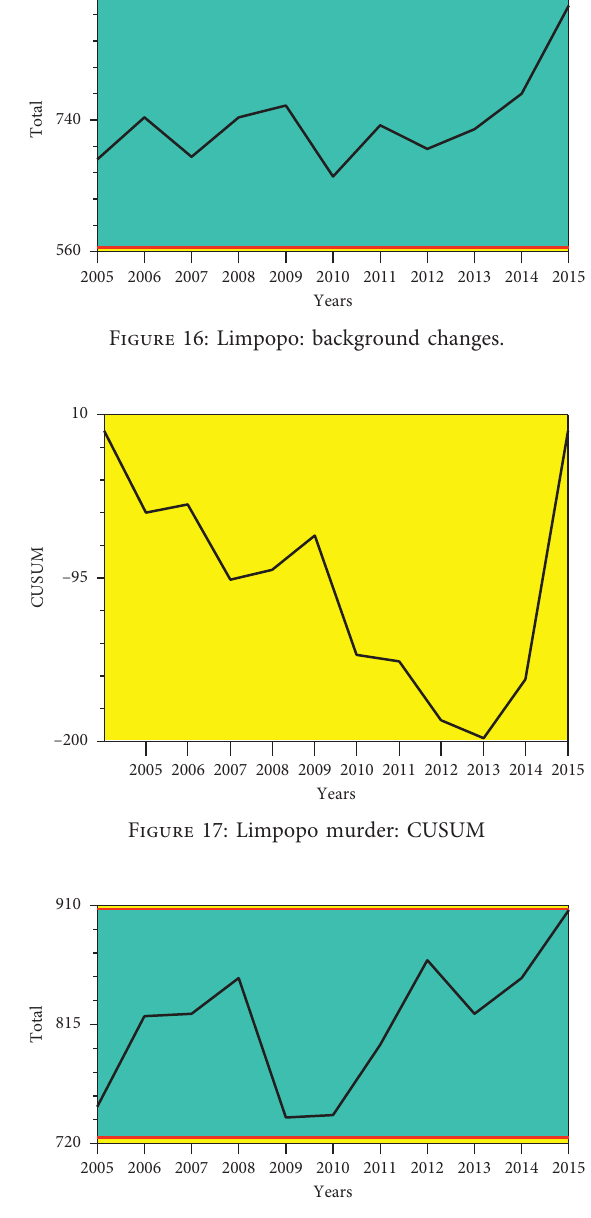
Figure 18: Northwest: background